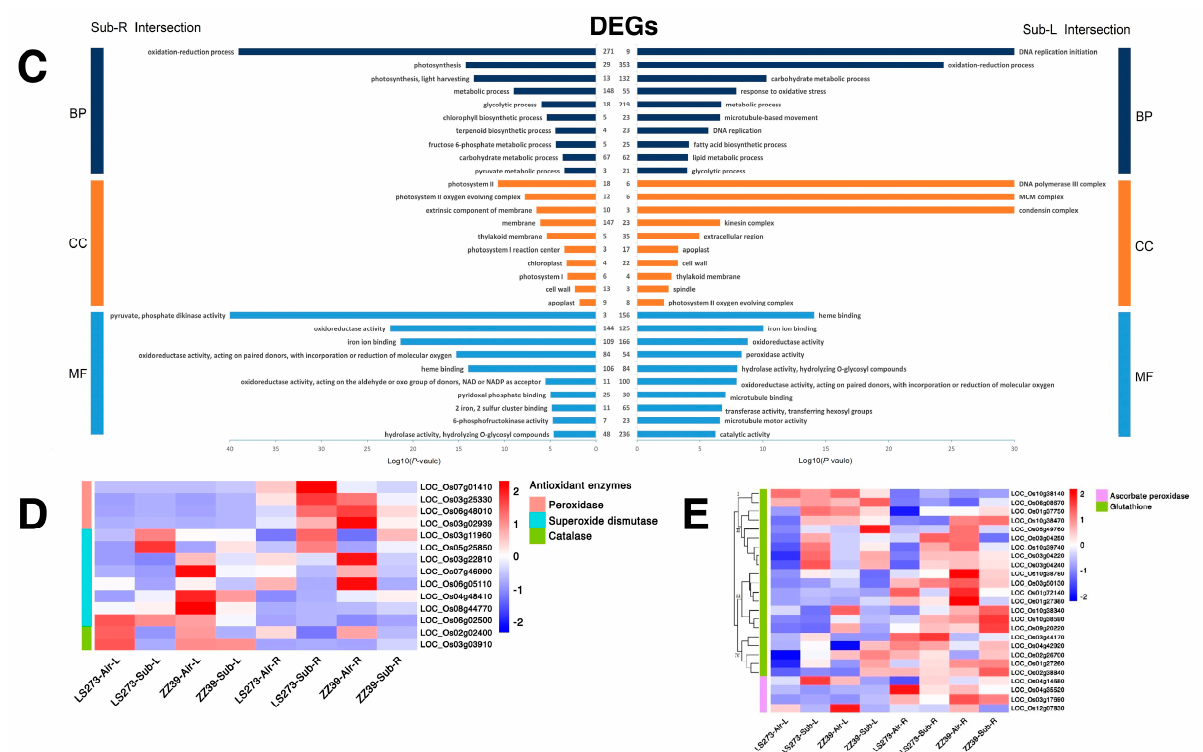
Figure 6. GO enrichment under submergence stress and expression of DEGs under the antioxidant system. ( A ) The enrichment results of DEGs in shoots; ( B ) the enrichment results of DEGs in roots; ( C ) enrichment results of shared DEGs in shoots and roots; ( D ) expression of DEGs in antioxidant enzyme system; ( E ) expression of DEGs in glutathione cycle. BP: Biological Process; CC: Cell Component; MF: Molecular Function; I, II, II and IV: Cluster analysis type.